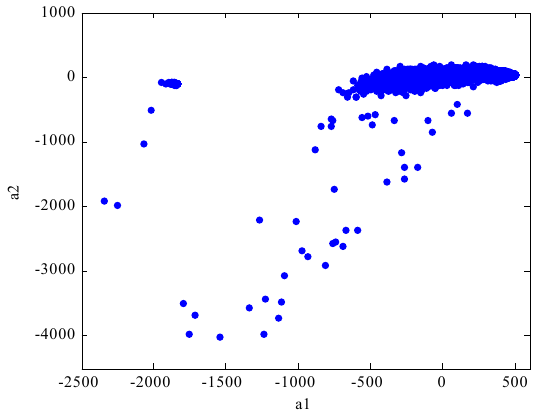
Figure 4. Loadings plot of the PARAFAC model for the sample mode ( a 1 versus a 2), a 1 and a 2 are the first two columns of the loading matrix A.